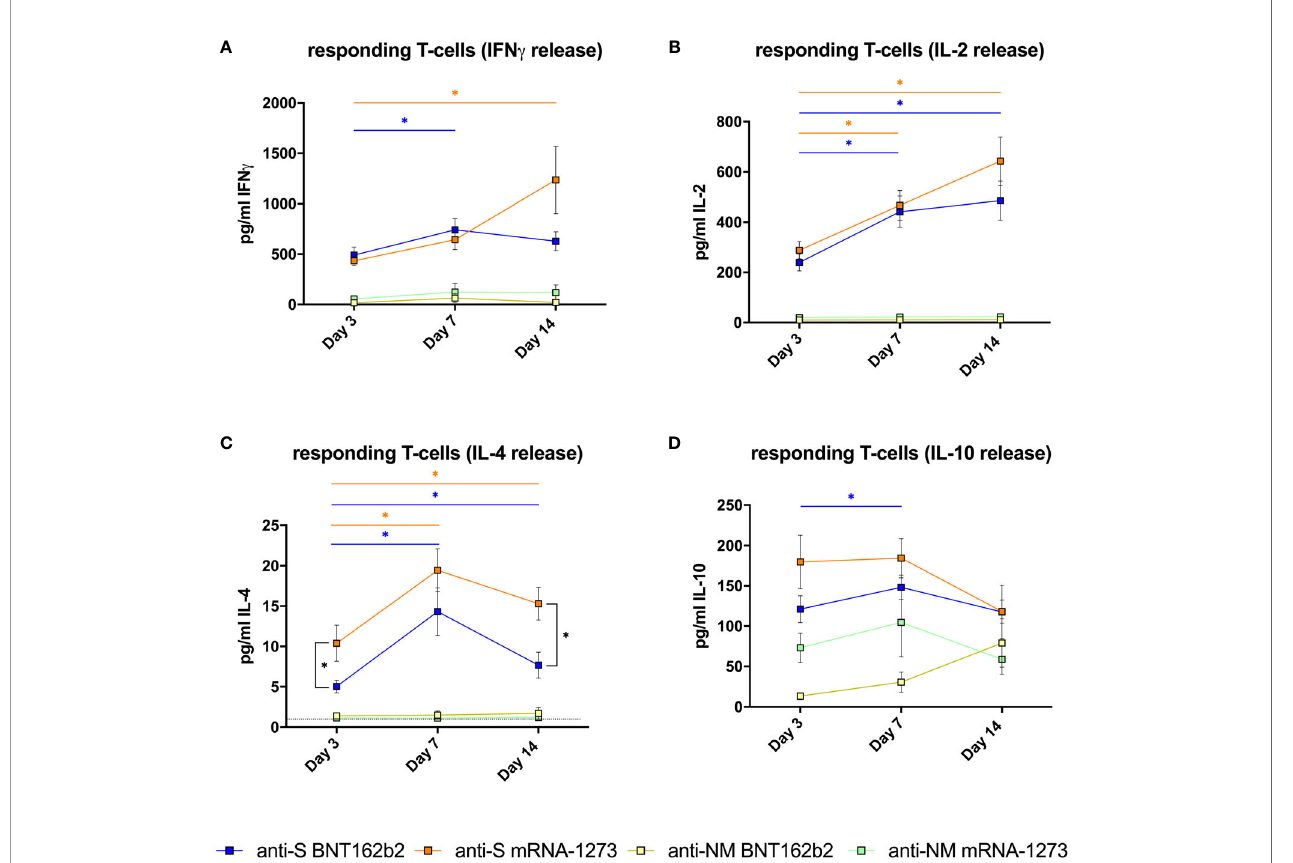
FIGURE 2 | Speci fi c T-cell responses in vaccinated healthy subjects. (A) Mean±SEM T-cell responses measured by IFN g release (pg/ml); (B) IL-2 release (pg/ml); (C) IL-4 release (pg/ml) and (D) IL-10 release (pg/ml) (D) after in vitro stimulation with spike-derived peptides pool (S) or mixed nucleocapsid and membrane peptides (NM) from volunteers vaccinated with BNT162 (n=21) or mRNA-1273 (n=19) after 3, 7 and 14 days of receiving the second dose of the vaccine. The dotted line in (C) indicates the lower detection limit of the method for this cytokine, showing that the low concentrations detected are reliable. The linear mixed model was adjusted to evaluate each immunological covariate ’ s evolution over time in each group. *Signi fi cant difference when p <